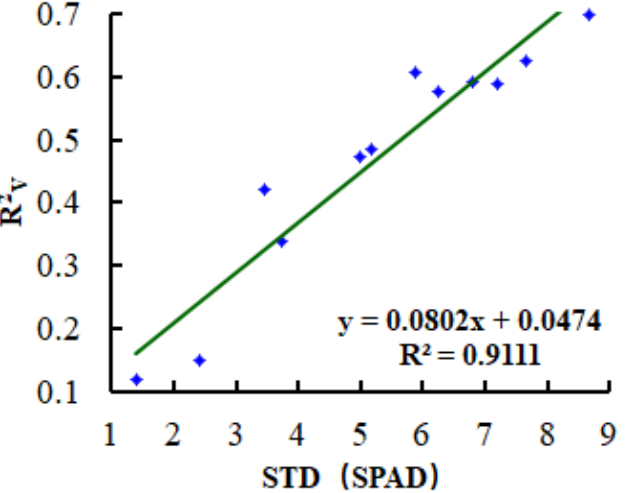
Figure 19. The correlation diagram of model R 2 V and standard deviation of sample SPAD values.